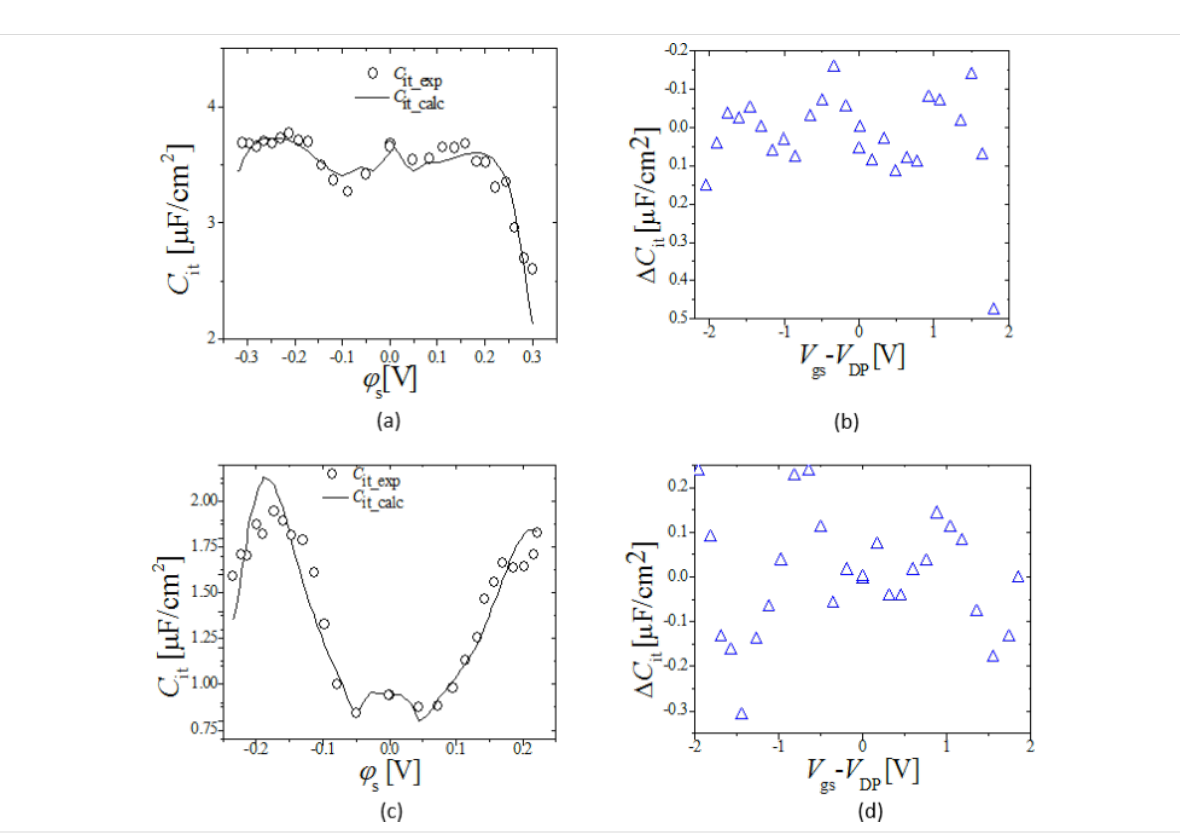
Figure 7: (a) and (c). C it for Device 1 and 2 respectively, symbols: C it_exp from Equation 6 as a function of φ s_exp , line: C it_calc calculated from Equa- tion 8–11 as a function of φ s_calc . (b) and (d) show the difference between C it_exp and C it_calc as a function of V gs for Device 1, and 2 respectively.